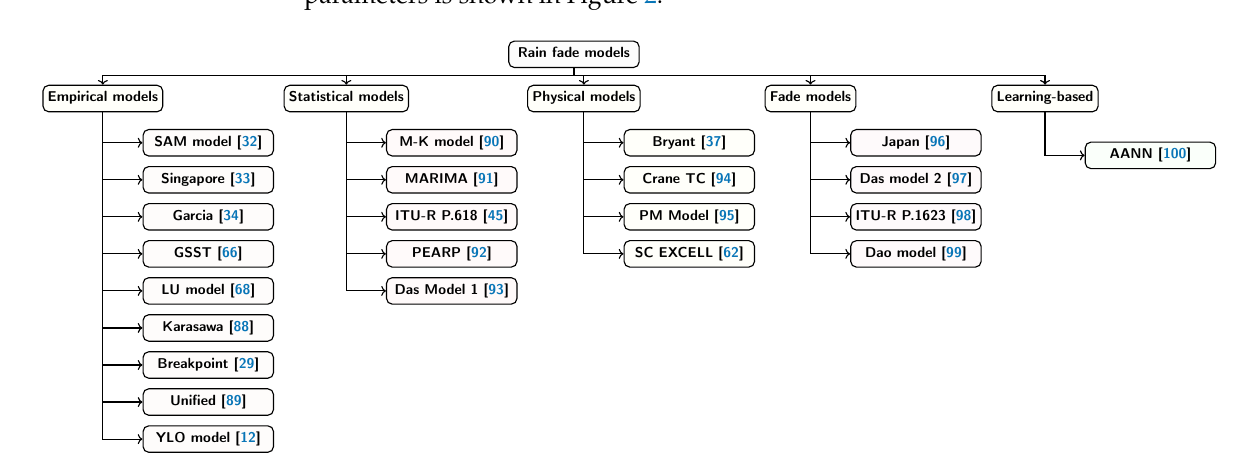
Figure 3. Taxonomy of the rain fade models for Earth–space links